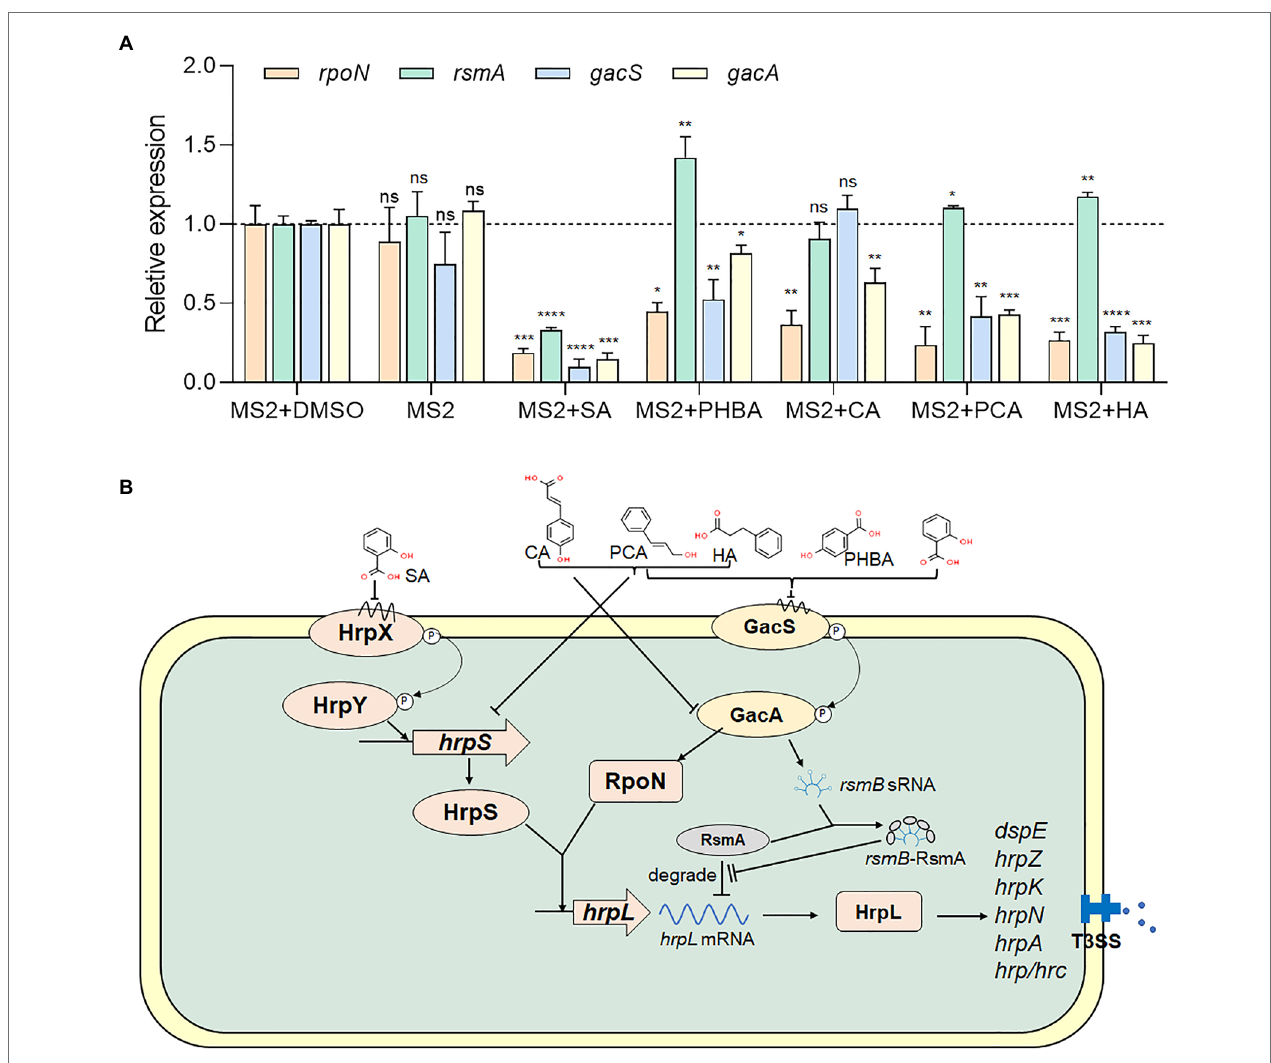
FIGURE 5 | Regulation of SA, PHBA, CA, PCA, and HA on T3SS. (A) Effects of SA (0.15 mM), PHBA (0.4 mM), CA (0.2 mM), PCA (0.2 mM), and HA (0.5 mM) on the expression of rpoN , rsmA , gacS , and gacA . RNA was collected at a bacterial concentration of OD 600 of 0.8. The cDNA levels of different samples were quantified by RT-PCR using a SYBR Green Master Mix. A housekeeping gene atpD was used as an endogenous control for data analysis. All gene expression under compound treatment or no solvent (MS2) was compared with that of MS2 + DMSO using Student’s t -test analysis (Graphpad Prism 8.4.3). Three independent tests were performed with similar results (ns, no statistical significance, * p < 0.05, ** p < 0.01, *** p < 0.001, and **** p < 0.0001). (B) Regulatory network controlling the Dickeya zeae T3SS. In Dickeya bacteria, the expression of T3SS is regulated by a master regulator, HrpL (Hu et al., 2022). On one hand, hrpL upregulates many hrp genes that encode the T3SS structural and functional proteins, such as hrpA , hrpN , and dspE (Hu et al., 2022). On the other hand, the expression of hrpL is regulated by the HrpX/HrpY-HrpS-HrpL pathway at the transcriptional level and the GacS-GacA-RsmB-RsmA pathway at the post-transcriptional level